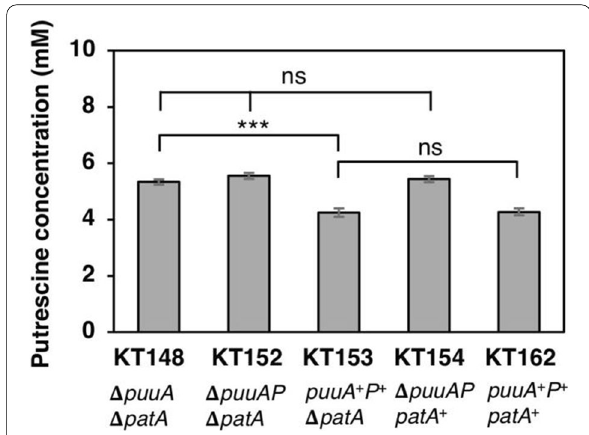
Fig. 6 Effects of patA , puuA , and puuP genes on the putrescine production. The amount of putrescine in the culture supernatant of the strains KT148, KT152, KT153, KT154, and KT162 grown in LB medium supplemented with 100 μg/mL of ampicillin for 48 h. When the OD 600 reached 0.4, 0.03 mM IPTG was added. ***, p < 0.001; ns, not significantly different. Data shown are averages standard deviations, ± and culture experiments were performed in triplicate